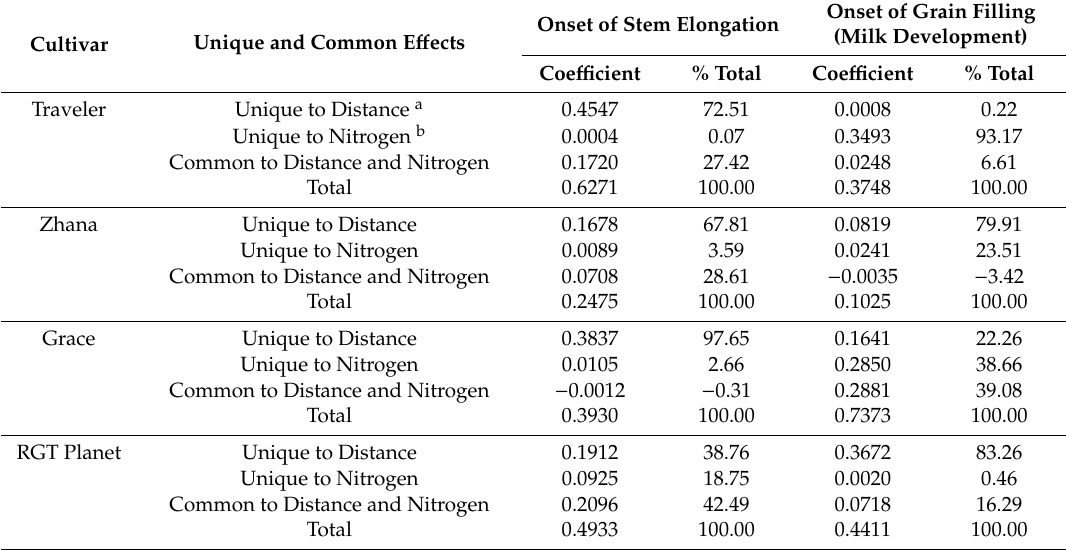
Table 2. Commonality coe ffi cients including both unique and common e ff ects, along with % total contribution of each predictor variable or sets of predictor variables to the regression e ff